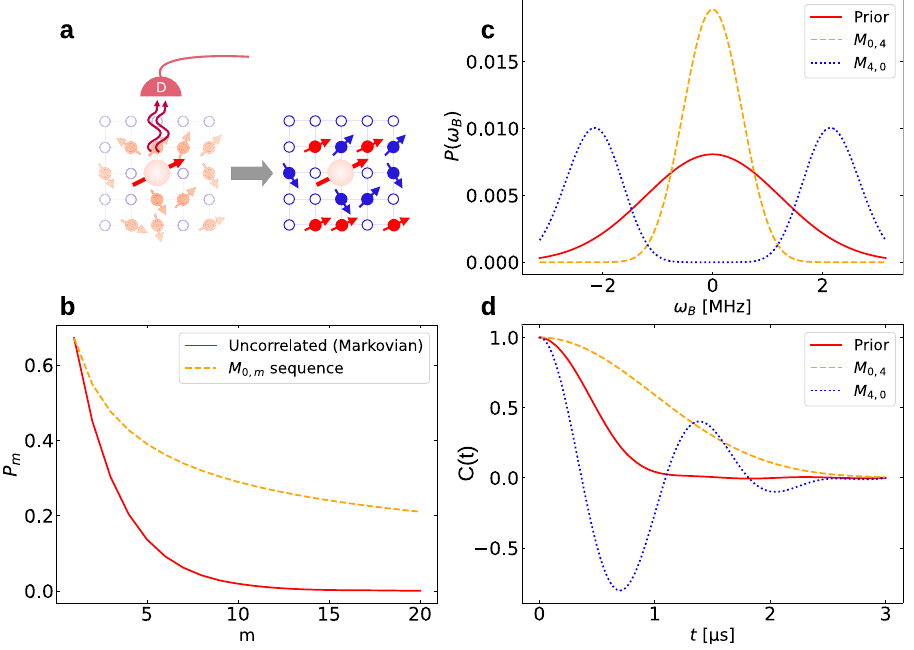
Fig. 1 | Bath puri fi cation by conditional selective measurements and it ’ s pos- terior (persistent) effects. a Schematic description: Conditional selective mea- surementsofthestateofthecentralprobe-spin(S)surroundedbyaspinbathinthe star con fi guration. The conditional measurements consist of photon-emission detection from the decayed state or non-detection from the initial state. A sequence of measurement events collapses the spin-bath toward a low entropy state with resolvable, partly-(red) or fully-polarized (orange) spins. b The success probability, p m of m positive measurement outcomes: solid red — for a probe sub- jecttouncorrelated(Markovian)measurementsequence(solidred)thatleavesthe spin-bath unchanged, dashed orange — for a probe subject to correlated measure- mentsthatpurifythebath.Thesuccessprobabilityexponentiallydecayswith m for uncorrelated measurements, while it saturates for correlated measurements. c Simulatedbathspectrum P ( ω j )plottedforthecasespriortomeasurements(red —